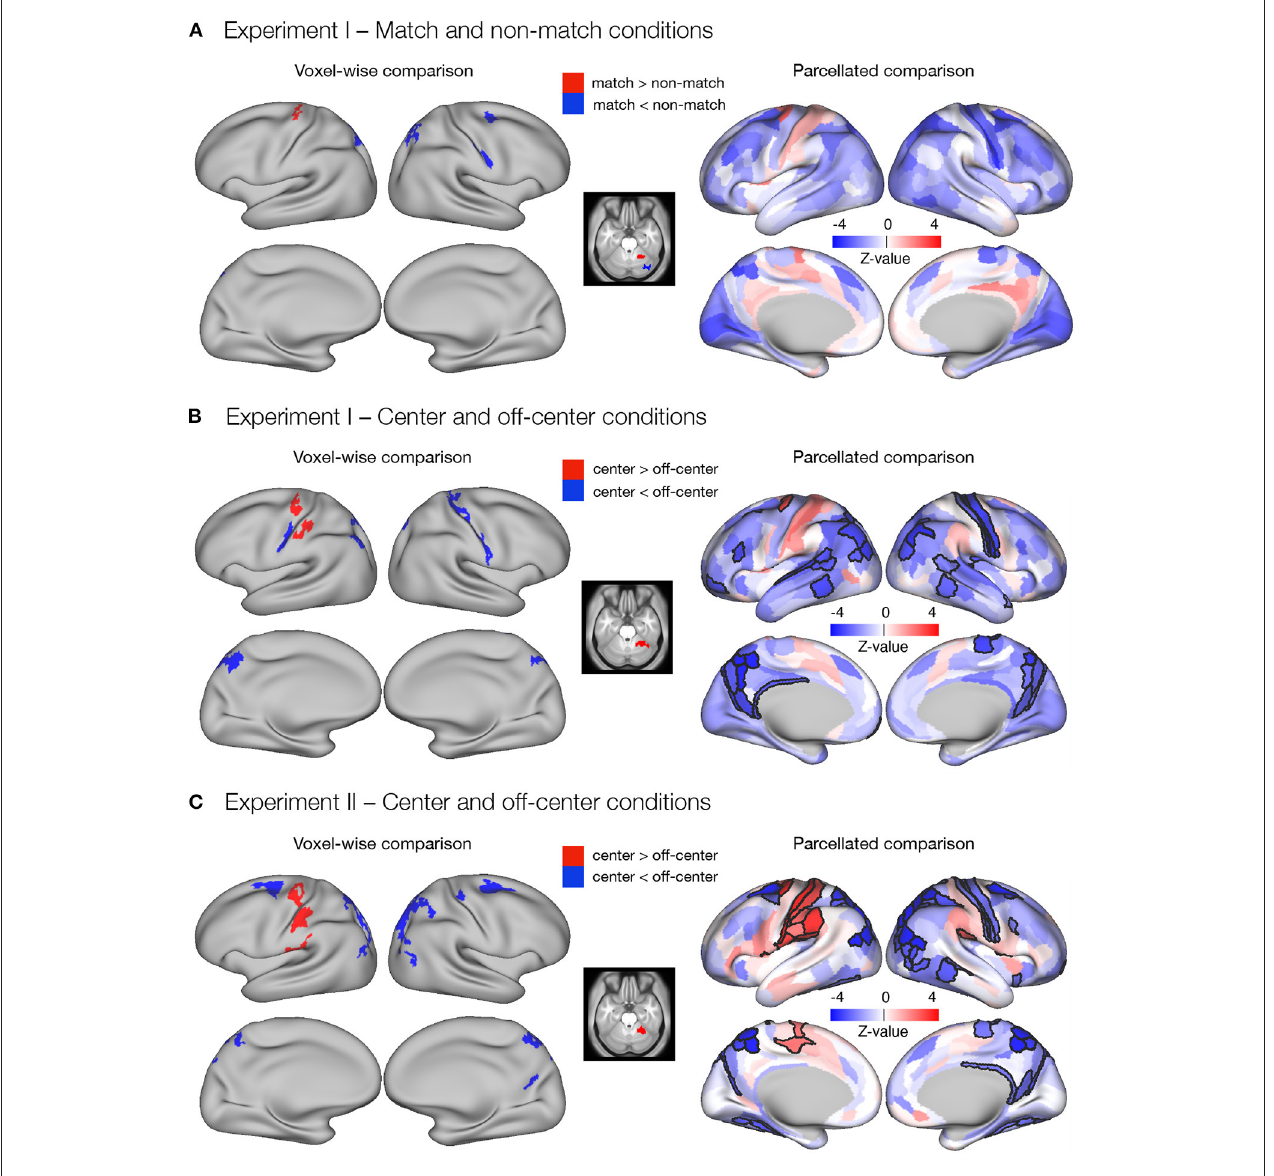
FIGURE 3 | Differences in the delay activity between task conditions thought to promote either retrospective sensory or prospective motor coding, respectively. Specifically, dense and parcellated results are presented for contrasts between (A) match and non-match conditions and (B) center and off-center conditions in Experiment I, and (C) center and off-center conditions in Experiment II. Voxel-wise comparisons were obtained by comparing delay-period activity between task conditions using permutation t -tests on dense whole-brain data, corrected with cluster ( C = 3.1) FWE, and thresholded at p < 0.05. For the parcellated comparisons, the dense whole-brain data were parcellated according to HCP-MMP1.0 parcellation (Glasser et al., 2016) before computing activity estimates. The significance of β estimates was computed using permutation t -tests and corrected for multiple comparisons with FDR. The resulting images of the parcellated data represent unthresholded maps of Z -values, while the black outlines mark the parcels that showed significant differences between task conditions, thresholded at q < 0.05.